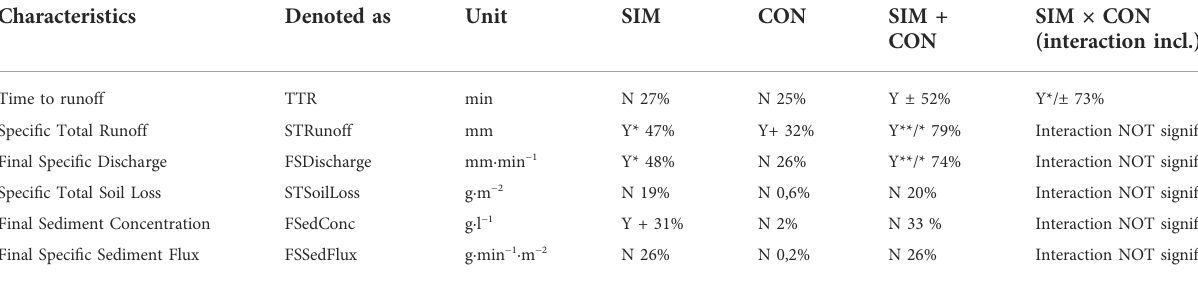
TABLE1ANOVA TypeIII, consideringtheresults obtained withtherainfallsimulationexperiments andhydrological parameters. Themeanings ofthe variables are: SIM, Simulator (plot) size; CON, initial moisture conditions. Y, yes, variable is signi fi cant; N, not a signi fi cant variable. Percentages showthefractionofexplainedvariability.Signi fi cancelevelsdenotedas:**( α =0.01),*( α =0.05),+( α =0.1),-(notsigni fi cant).Inmodelswithmultiple variables, the order of the alpha levels corresponds to the order of the variables, interaction term provided in the last position.